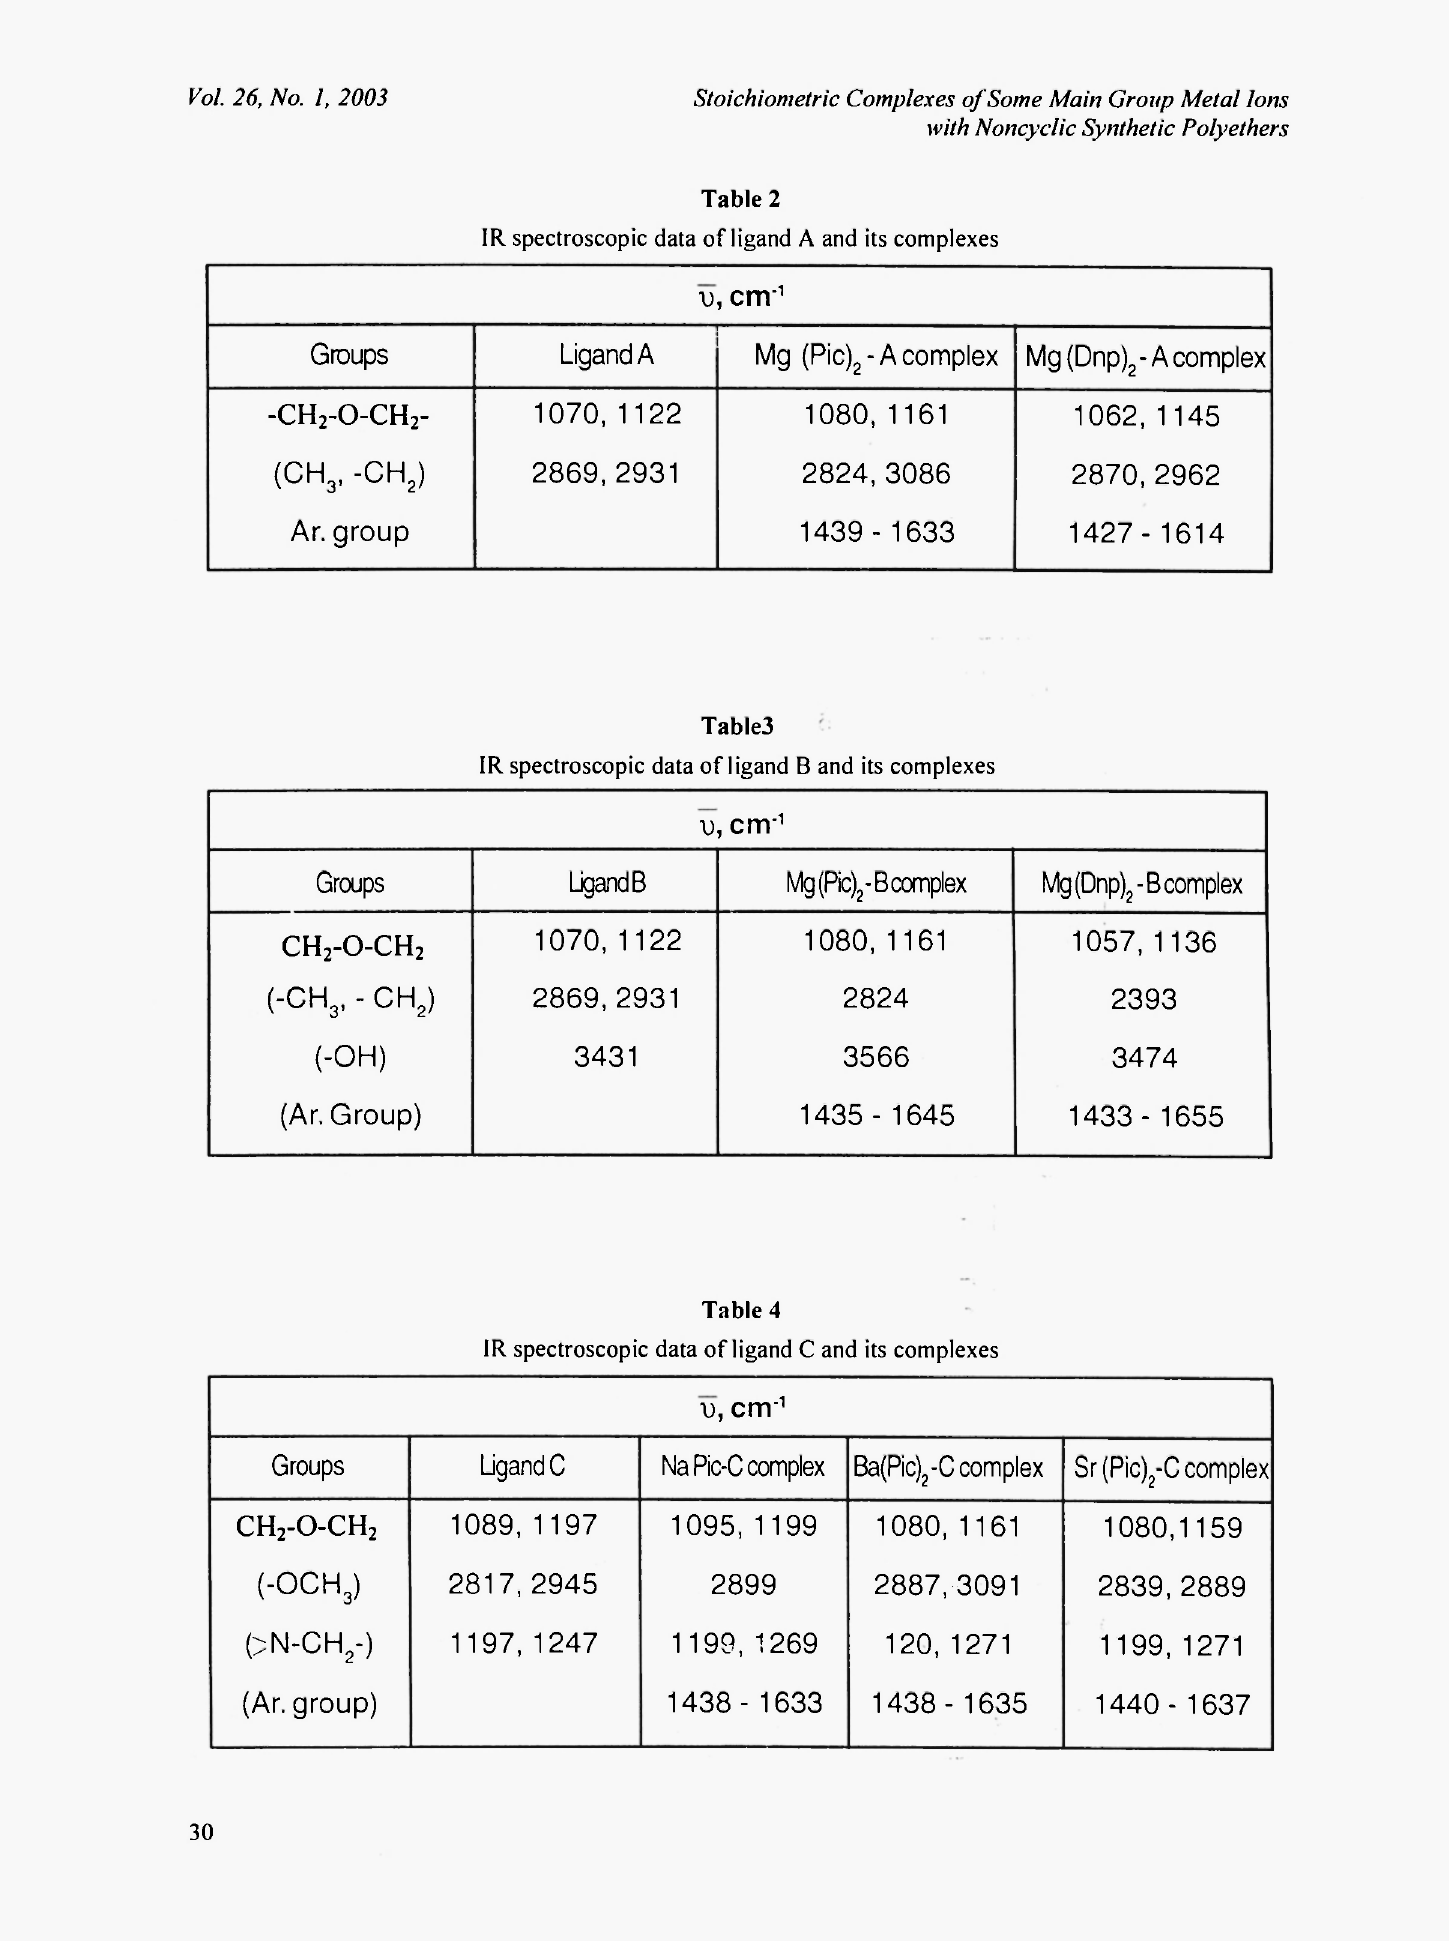
IR spectroscopic data of ligand A and its complexes